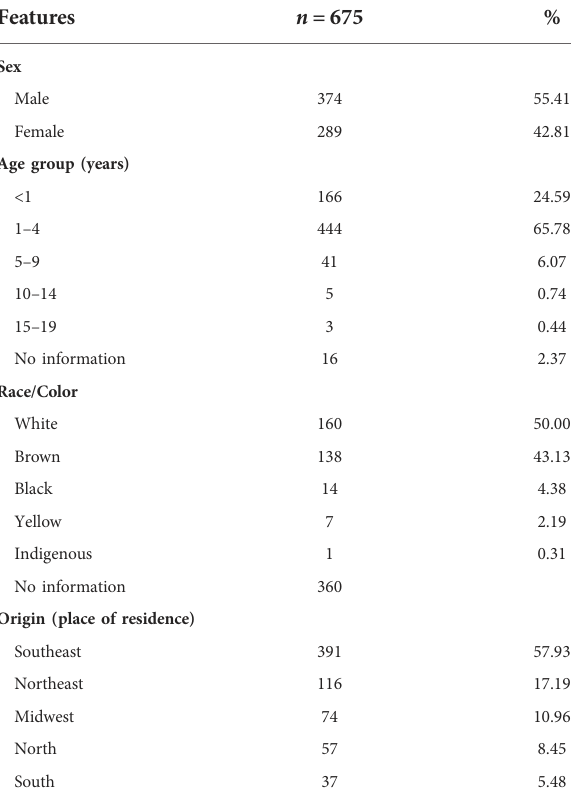
TABLE 1 Demographic characteristics of retinoblastoma cases from the Population-Based Cancer Registry, 2000 – 2018, National Cancer Institute, Ministry of Health,